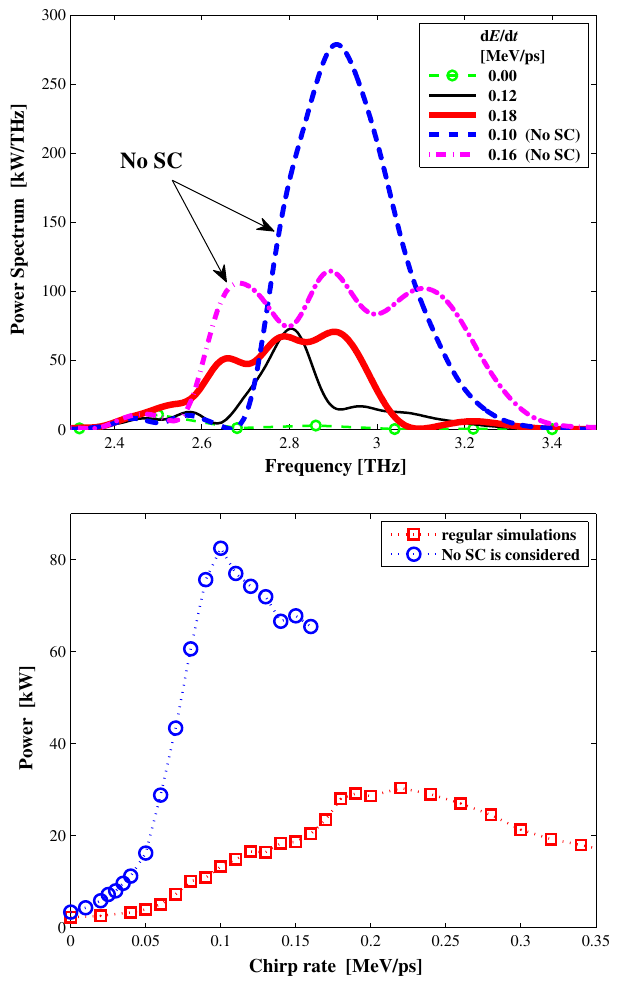
FIG. 10. Energy chirping of a N m ¼ 11 long premodulated beam: radiation power spectrum (top), and the total emitted power as function of the chirp rate (bottom). On both pictures, results of the simulations with the SC forces “ turned off ” are shown for comparison. The beam charge is Q b ¼ 1 nC, the initial modulation depth and frequency are m ¼ 50% and f 2 . 5 THz, respectively. m ¼